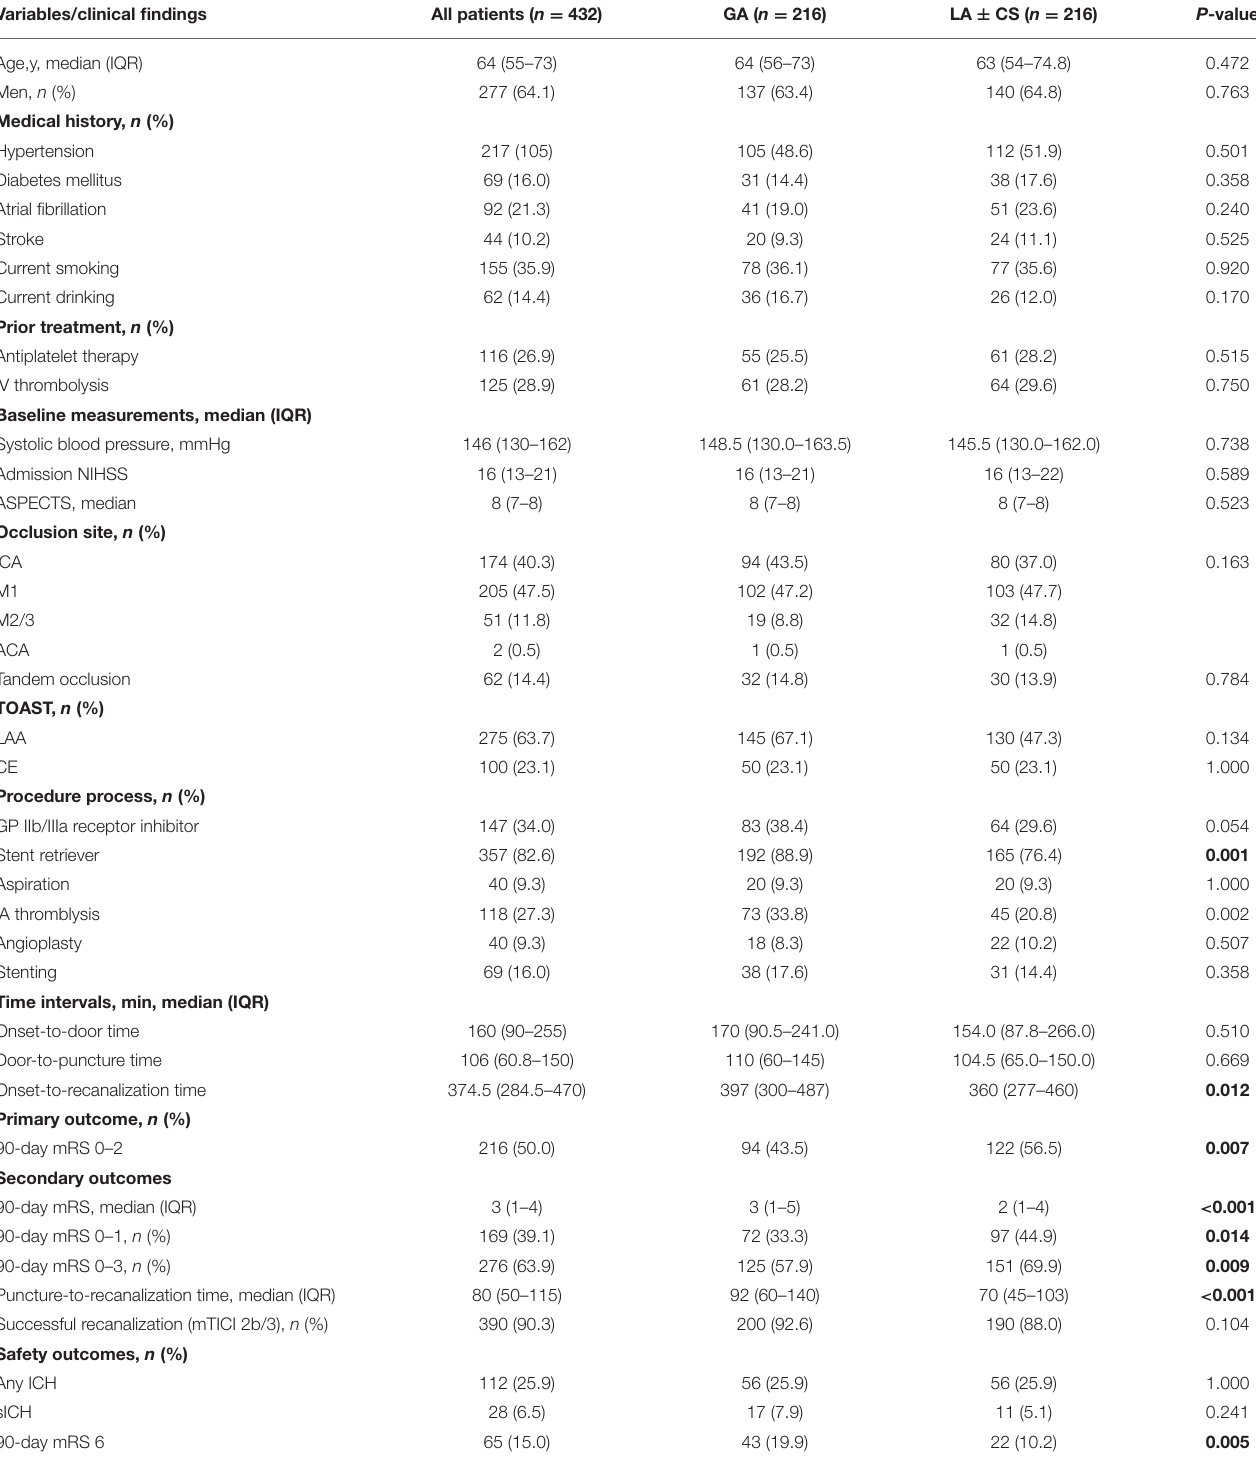
PSM, propensity score matching; IQR, interquartile range; IVT, intravenous thrombolysis; NIHSS, National Institutes of Health Stroke Scale; ASPECTS, Alberta Stroke Program Early CT Score; ICA, internal carotid artery; M1, middle cerebral artery M1 segment; M2, middle cerebral artery M2 segment; M3, middle cerebral artery M3 segment; ACA, anterior